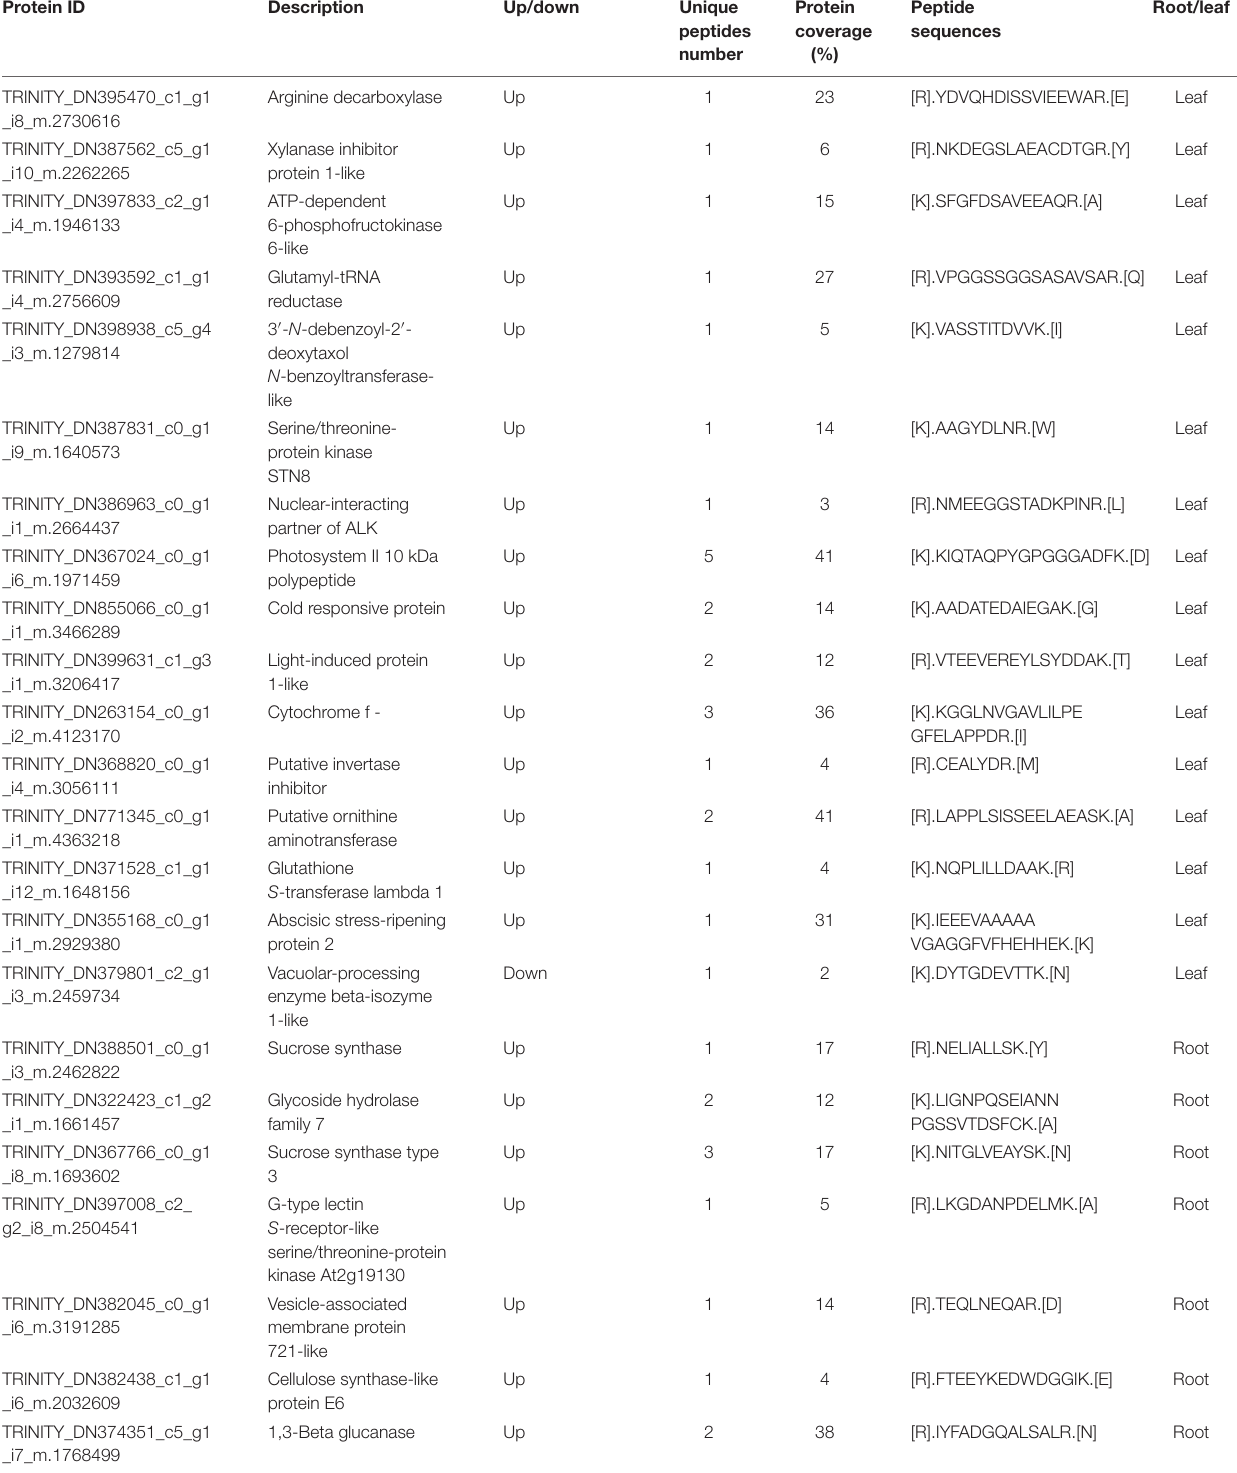
TABLE 2 | Some differentially expressed proteins related to alkali tolerance treated by exogenous spermine compared to alkali stress. Protein ID Description Up/down Unique